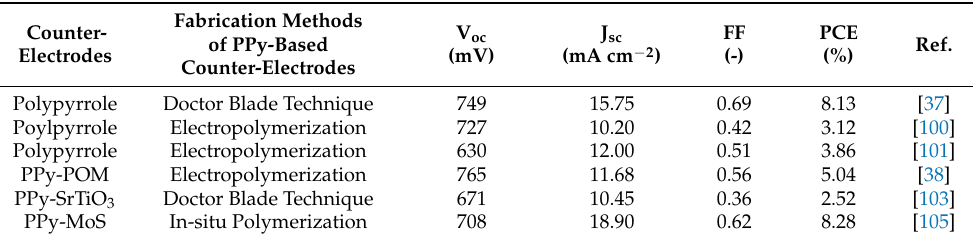
Table 3. Photovoltaic performance parameters of polypyrrole-based DSSCs counter-electrodes and their